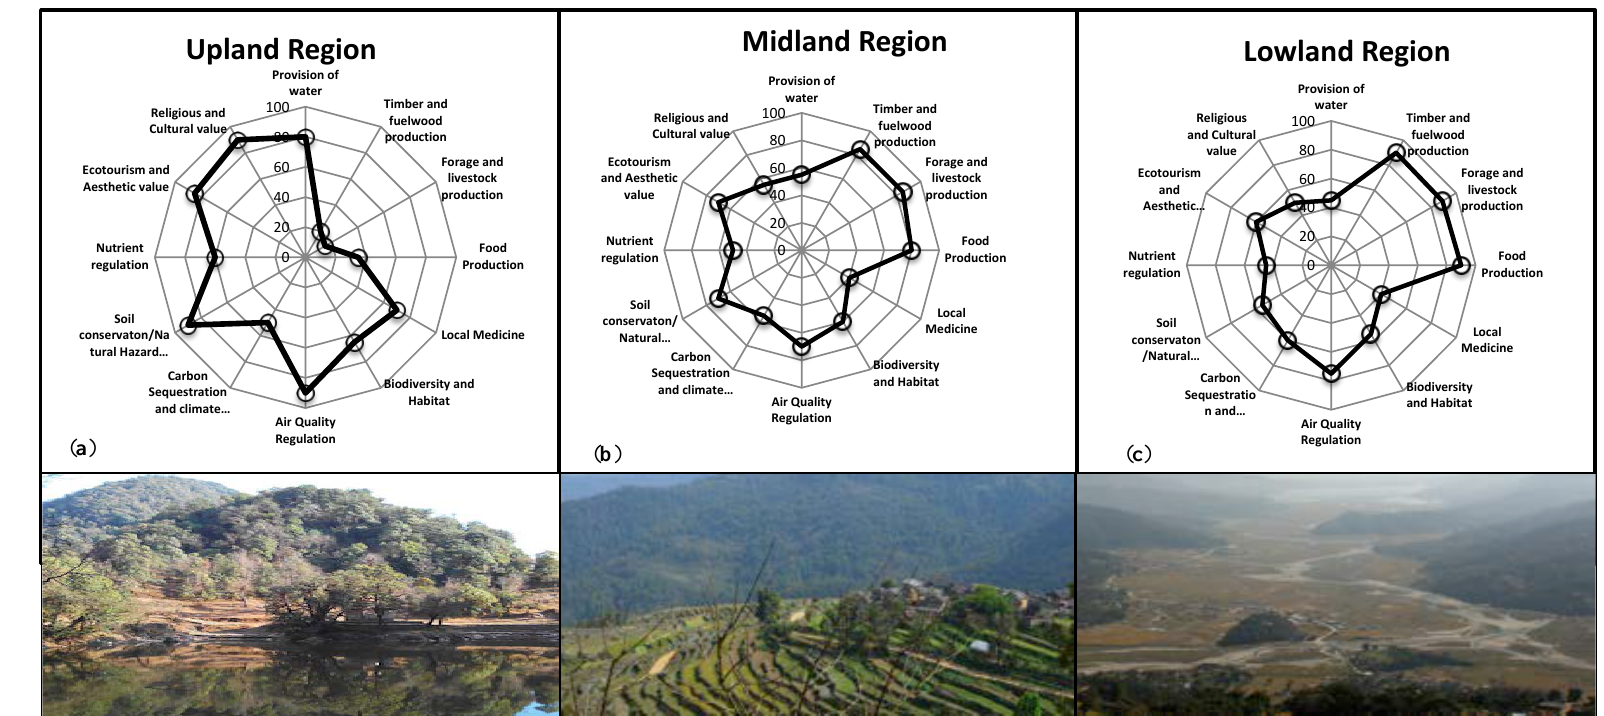
Figure 4. Prioritization of major ecosystem services (ES) by forest users in the upland ( a ), Midland ( b ), and lowland ( c ) region of PMER, Nepal.